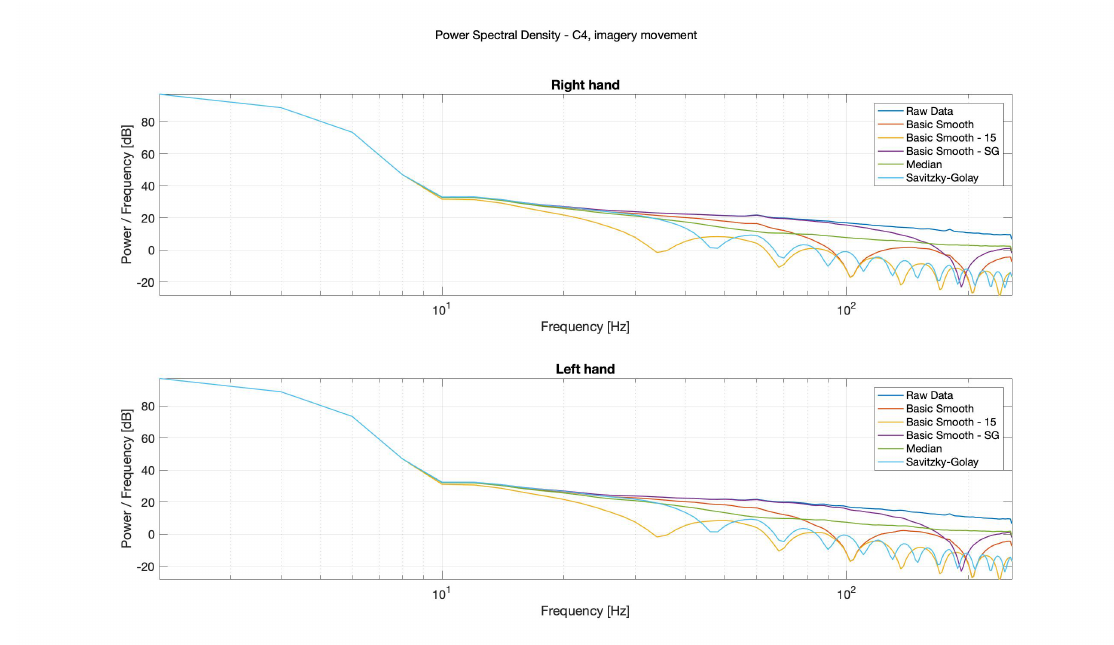
Figure 17. PSD—Bode plots, C4, imagery movement, right ( top ) and left ( bottom )